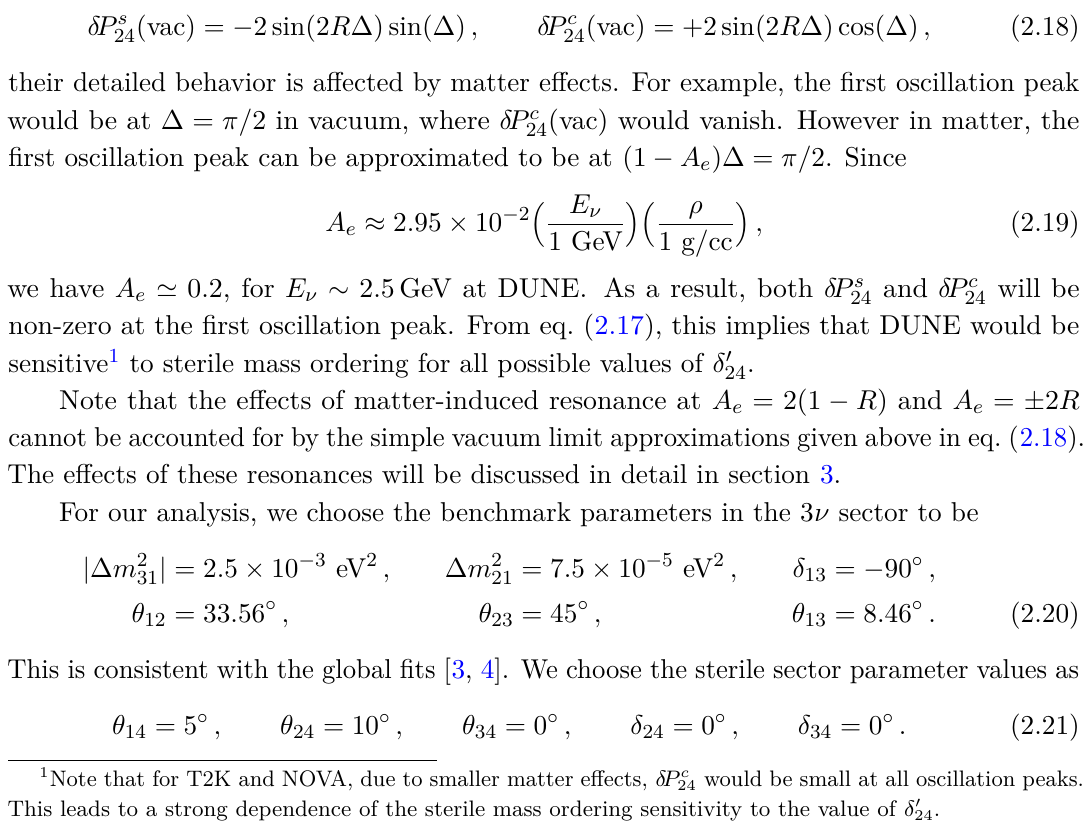
, δP c , δP s and δP c as functions of R = ∆ m 2 24 24 34 34 = 3 GeV [Right], for DUNE. The Horizontal dotted line are the bounds on the ν and δP c in the vacuum limit, obtained from eq. 24 24